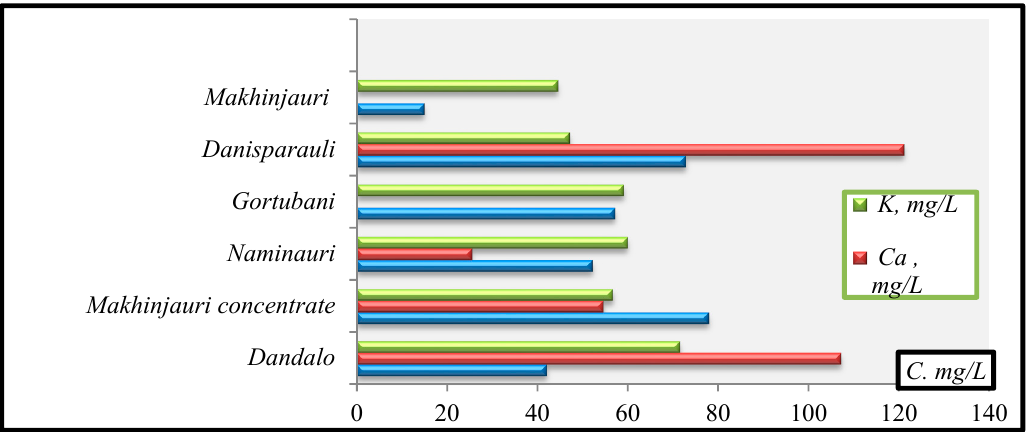
Figure 10. The content of K, Ca and Mg in the mineral waters.